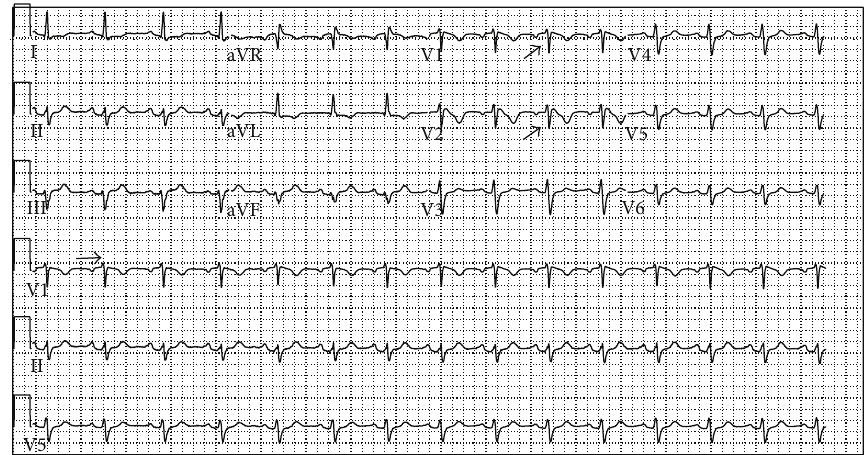
Figure 2: ECG at day 2. Observe the RBBB morphology with the coved-type ST-segment elevation of ≥ 2mm followed by a negative T wave.